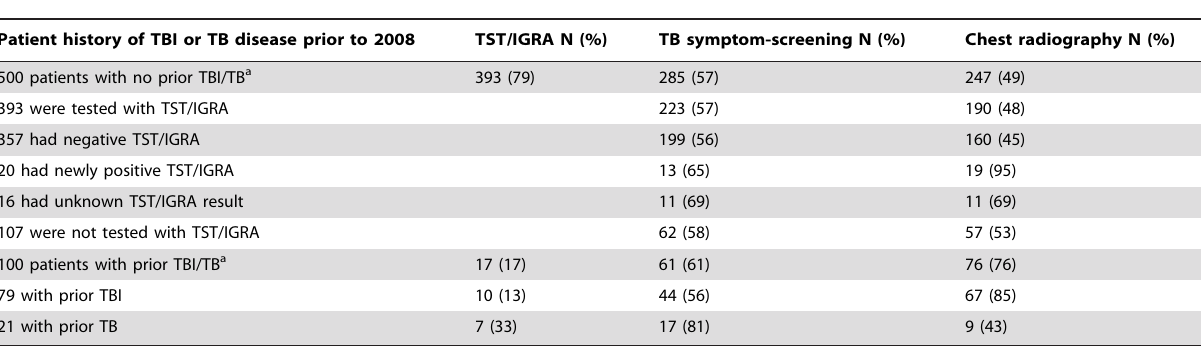
Table 2. Frequency and percent of patients who received TB services,